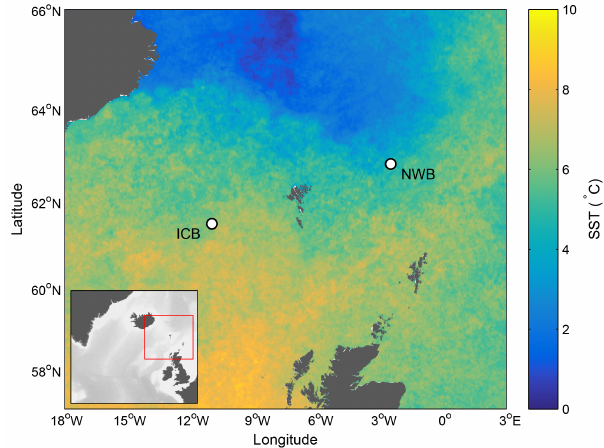
Figure 1. Sampling locations in the Iceland Basin (ICB) and the Norwegian Basin (NWB), superimposed on a composite of MODIS sea surface temperature for 25 March–29 April